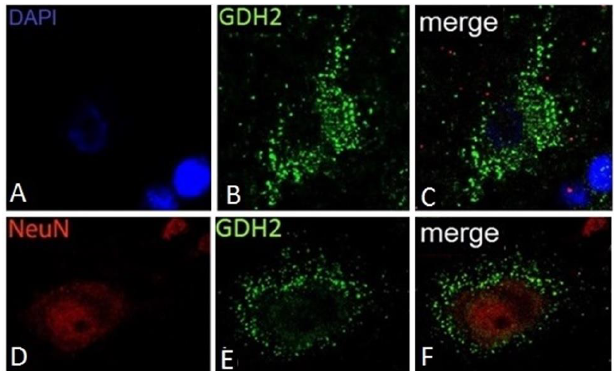
Figure 3. hGDH1 and hGDH2 expression in glial cells. Punctate immunoreactivity for hGDH1 ( A ) and hGDH2 ( B ) is present in the cytoplasm and along the proximal and distal processes of GFAP positive astrocytes (IF images of high magnification). Also, hGDH1-specific staining is detected in the nucleus of a GFAP positive astrocyte ( C,D,E ), of a connexin 47-positive oligodendrocyte ( F ) and of an NG2-positive oligodendrocyte-precursor ( G,H,I ) (IF images of unfixed human frontal lobe cortex. Blue staining represents DAPI labeled nuclei).